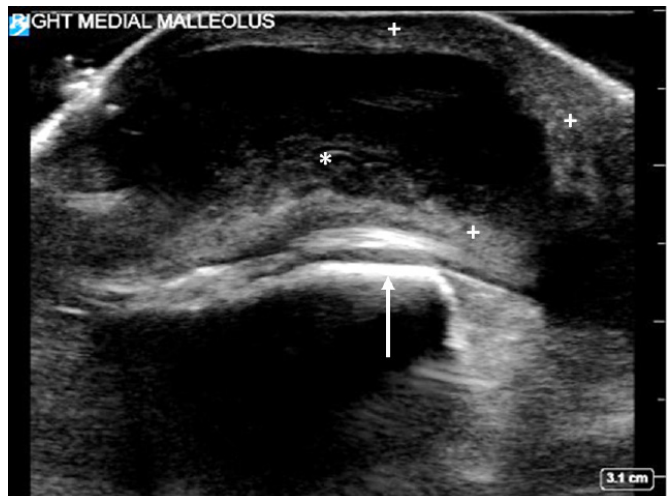
Image 2. Ultrasound demonstrating a thick-walled (plus signs) bursa containing complex fluid (asterisk), which overlies the medial malleolus